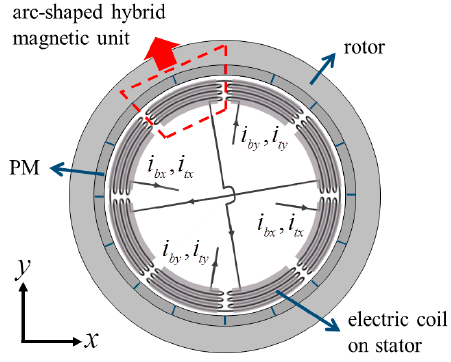
Figure 6. The winding scheme of HMB.